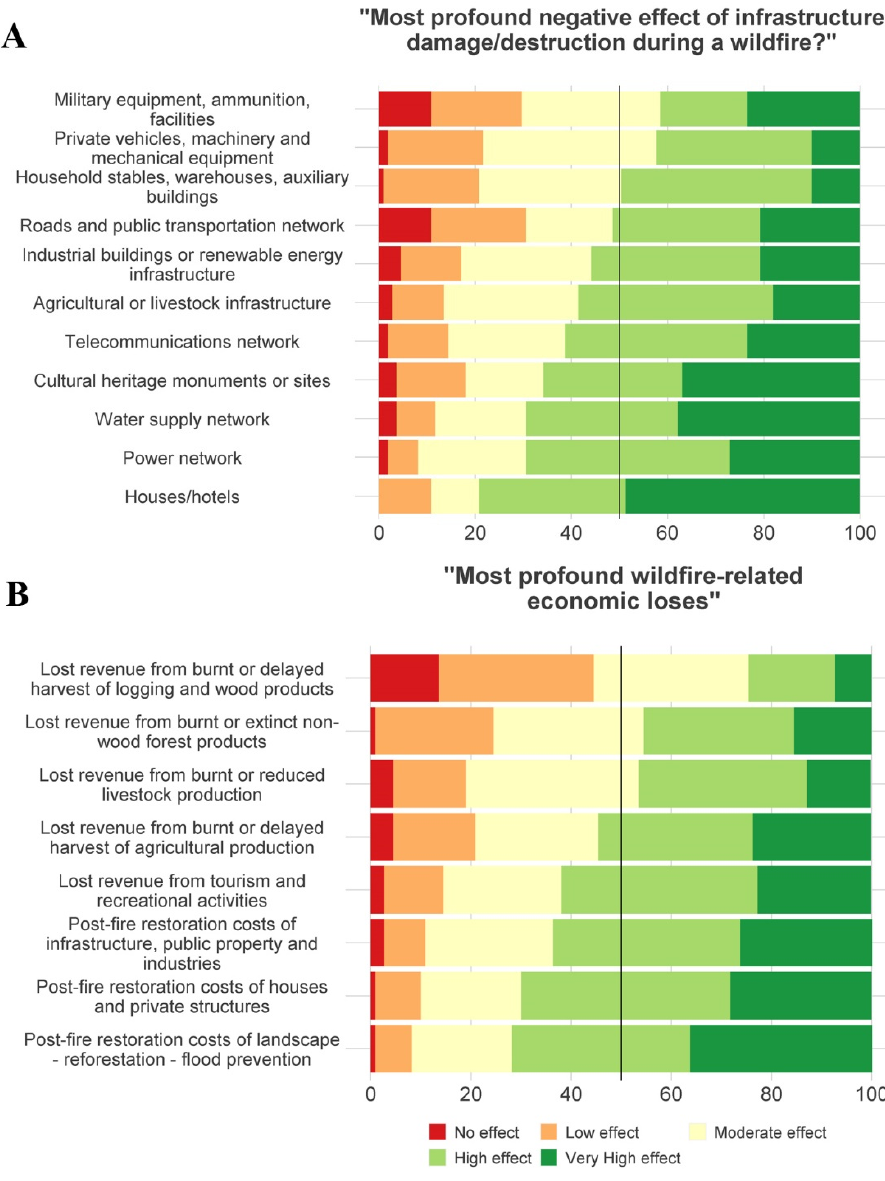
Figure 7. Likert scale rating of factors that cause ( A ) negative wildfire effects on infrastructure; ( B ) wildfire-related economic losses, expressed as a percentage of responses from survey results.